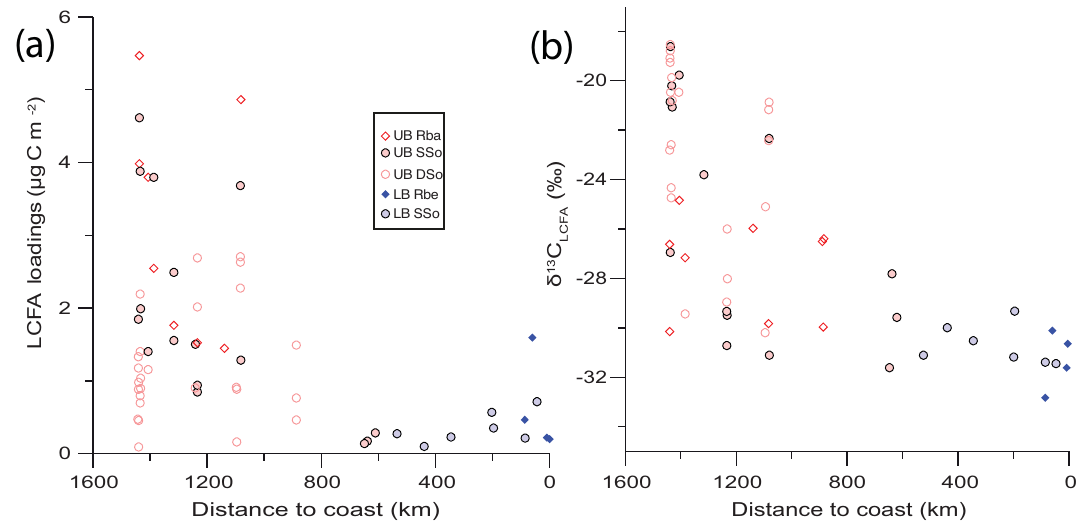
Figure 6. (a) LCFA loading vs. distance to coast. (b) δ 13 C LCFA vs. distance to coast for river basin samples. Symbol key and abbreviations are as for Figs. 1 to 3.